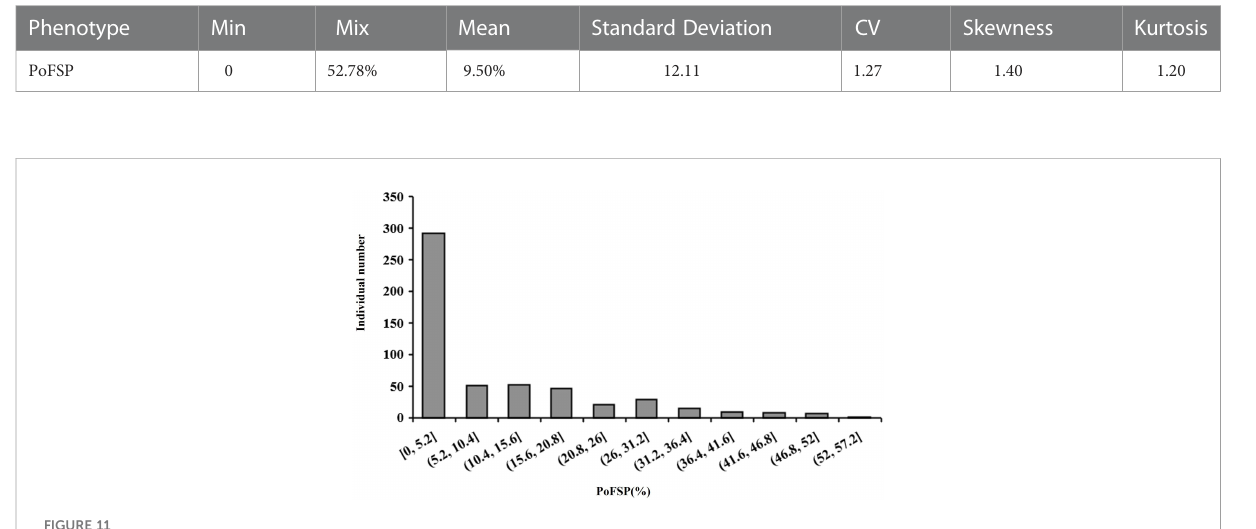
TABLE 4 Statistics analysis of PoFSP in the resource population.